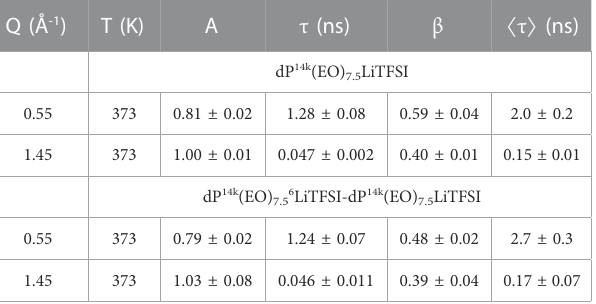
TABLE 2 Fitting results for the WASP data. Uncertainties represent standard errors.